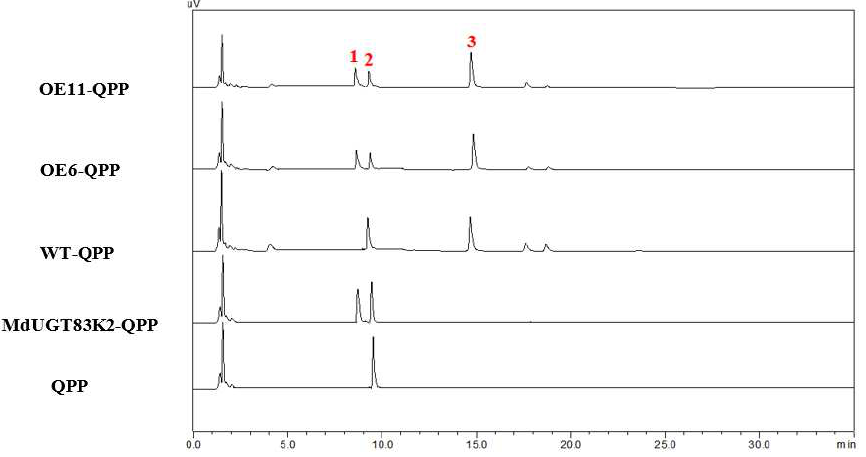
Figure 6. HPLC detection of QPP glycoside of various strains. For QPP glycoside extraction, tissue culture seedlings (normal culture for 3 weeks) of wild-type “Gala” and transgenic apple lines (OE6 and OE11) were treated with 10 μmol/L QPP for 12 h. 1, QPP glycosides; 2, QPP; 3, Internal reference “IBA”.